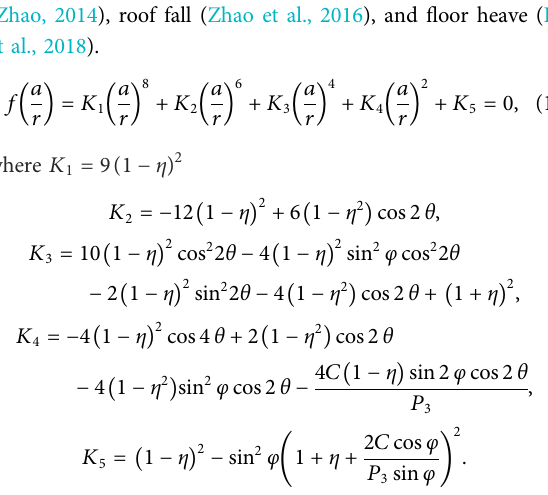
FIGURE 3 Stress distribution in AAAM.